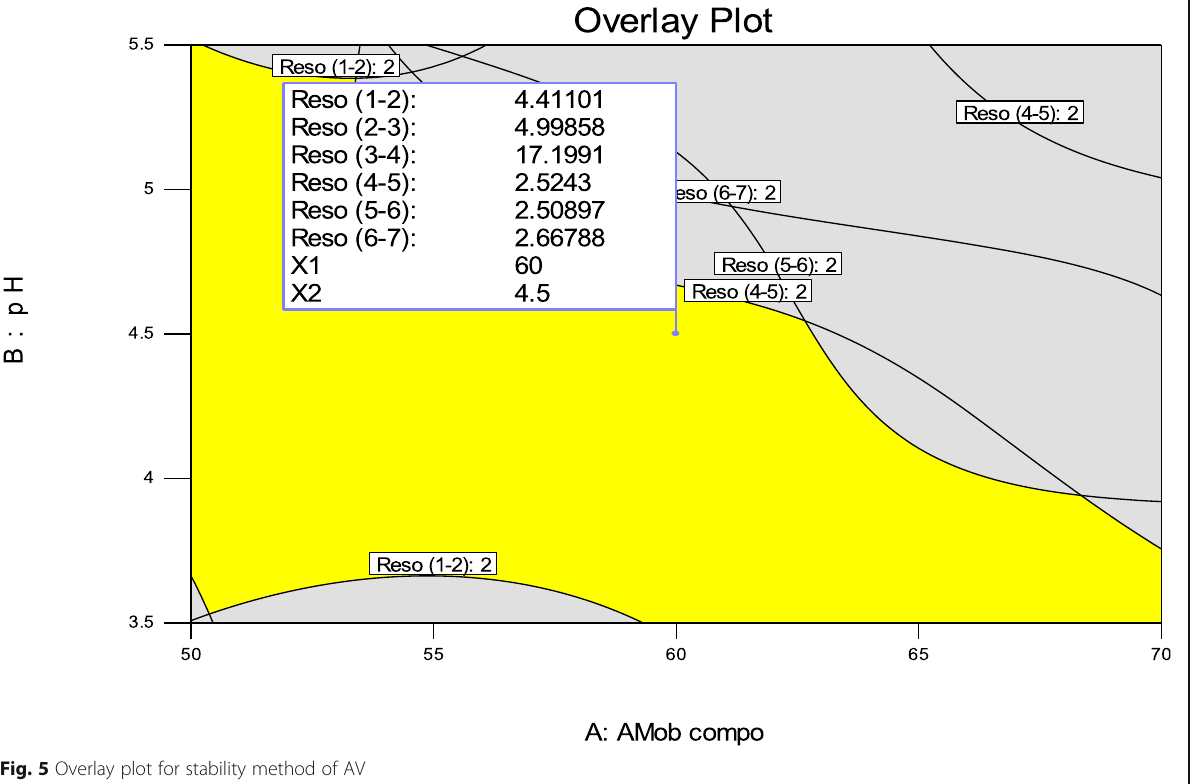
Fig. 5 Overlay plot for stability method of AV